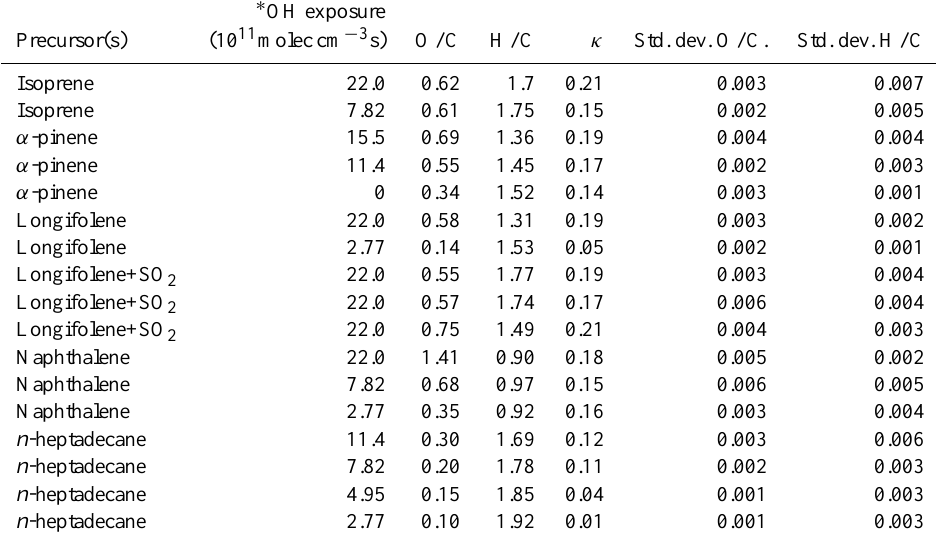
Table 1. SOA generation parameters and measurements. The third α -pinene line with ∗ OH exposure of 0 refers to an ozonolysis experiment. ∗ OH exposure